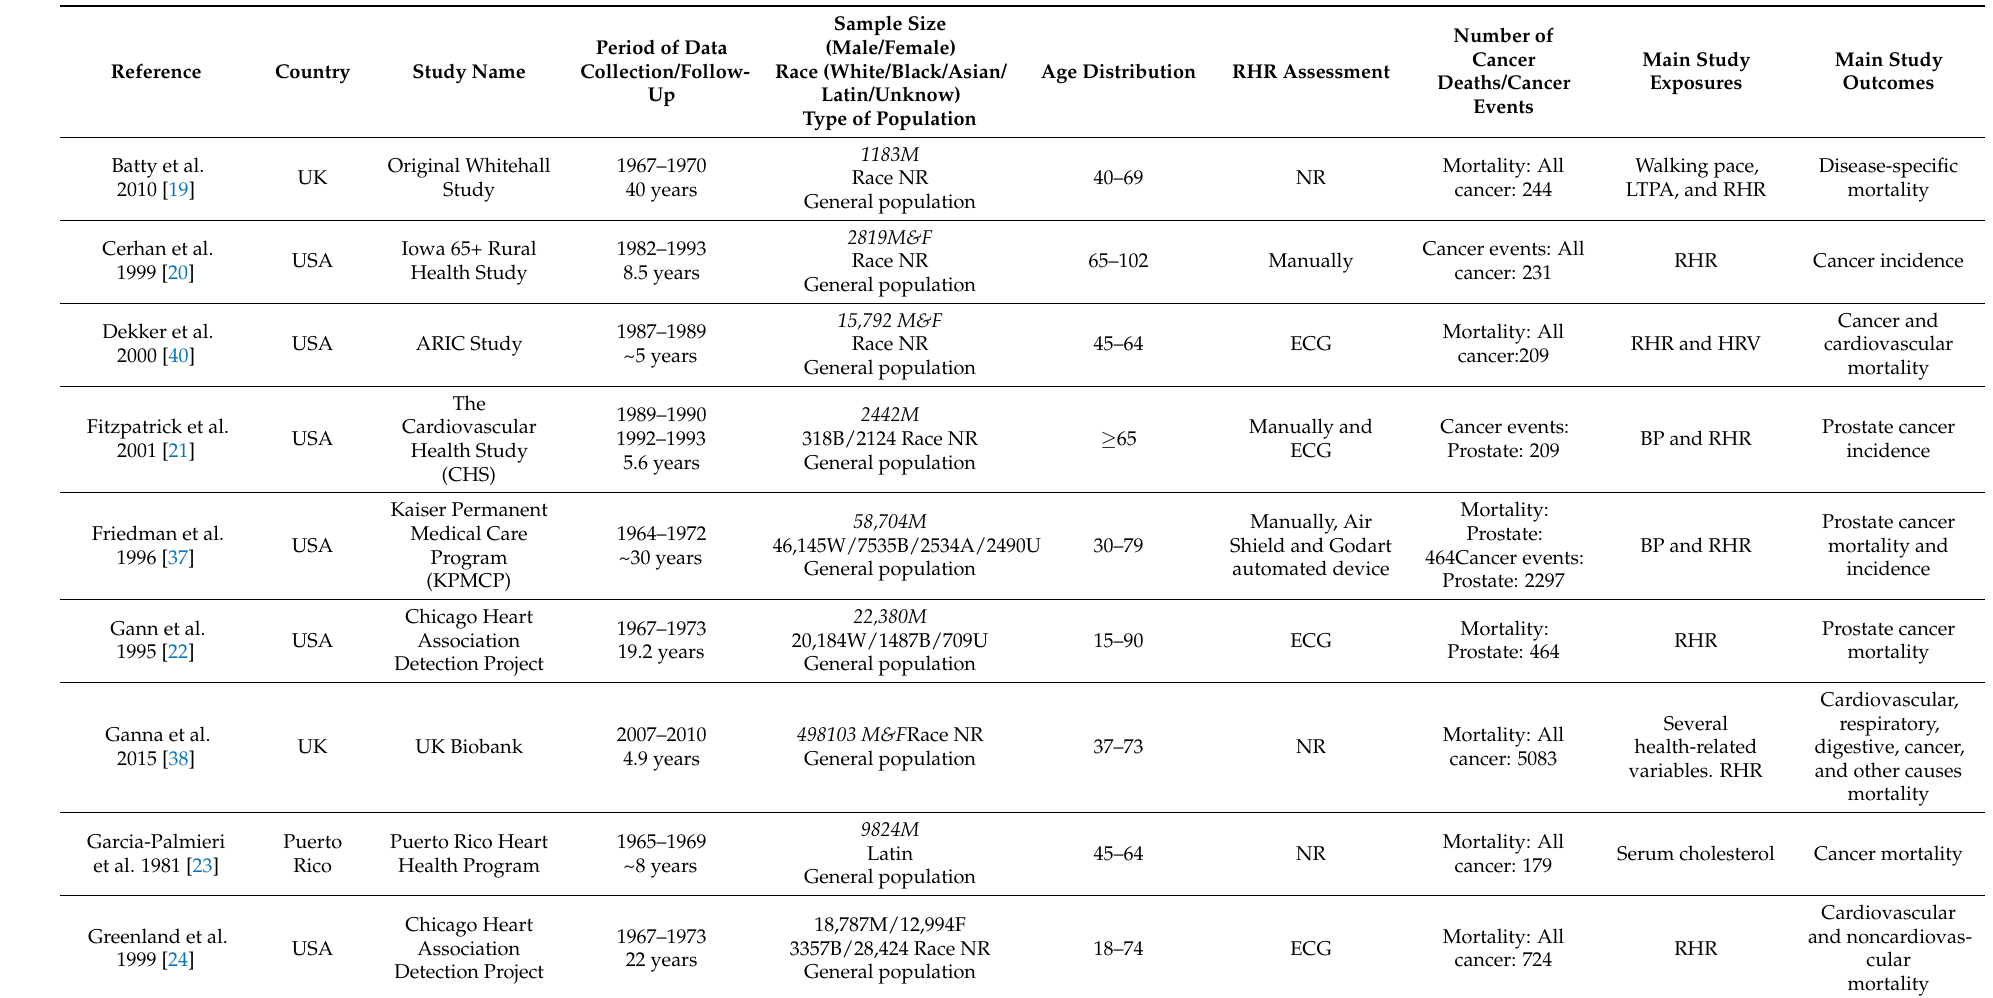
Table 1. Characteristics of studies included in the systematic